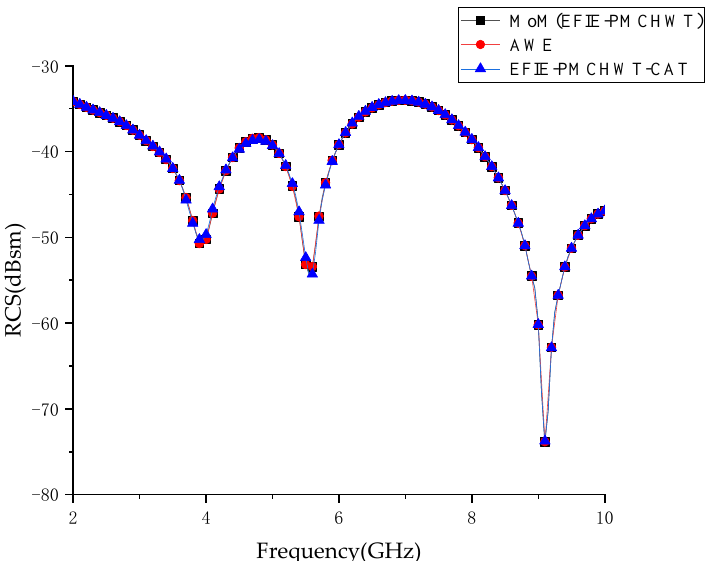
Figure 12. RCS frequency response of the coated boat of the MoM (EFIE-PMCHWT), AWE, and EFIE-PMCHWT-CAT.